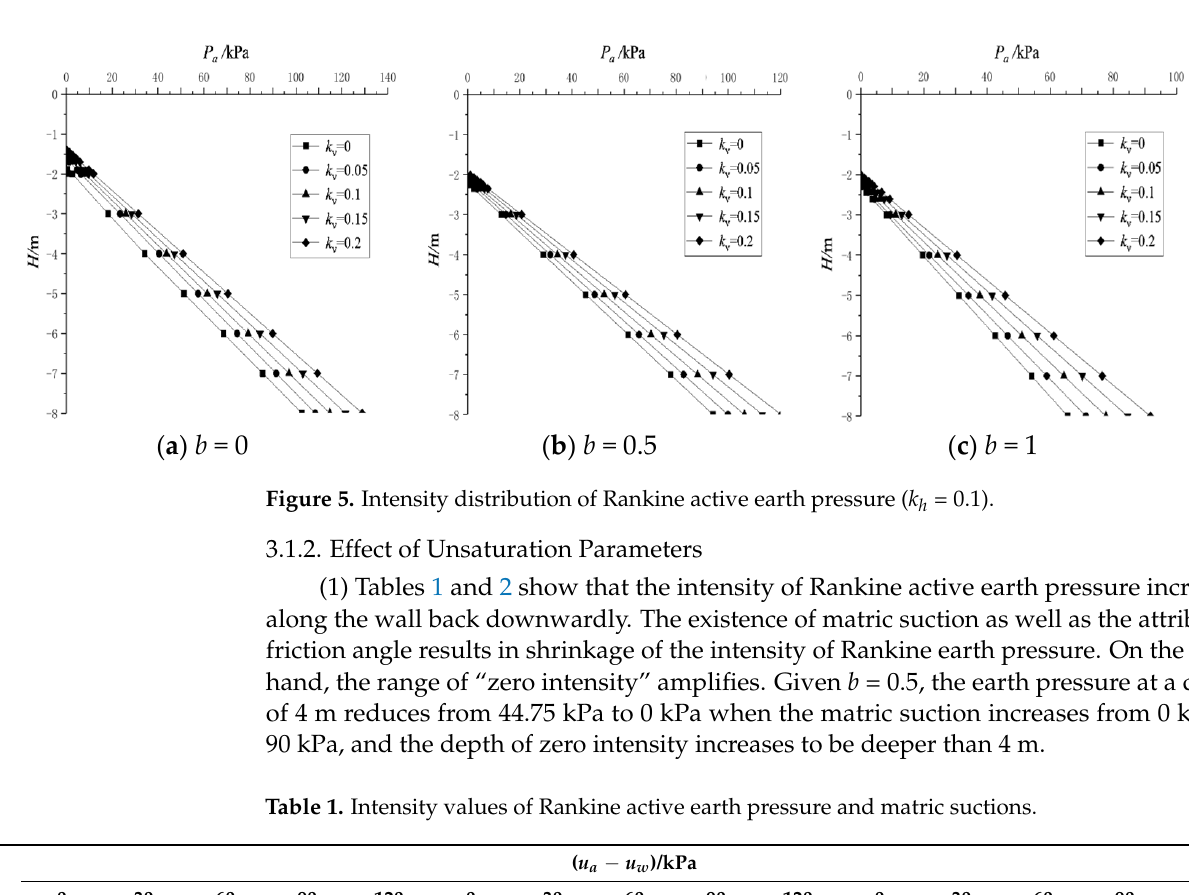
Table 1. Intensity values of Rankine active earth pressure and matric suctions.